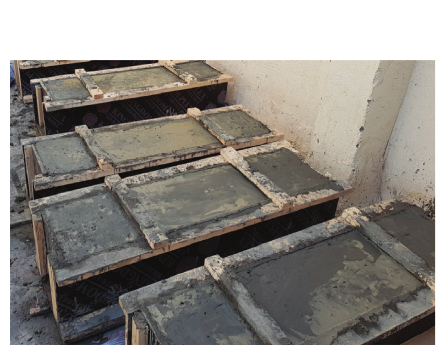
Figure 2: Casting of concrete